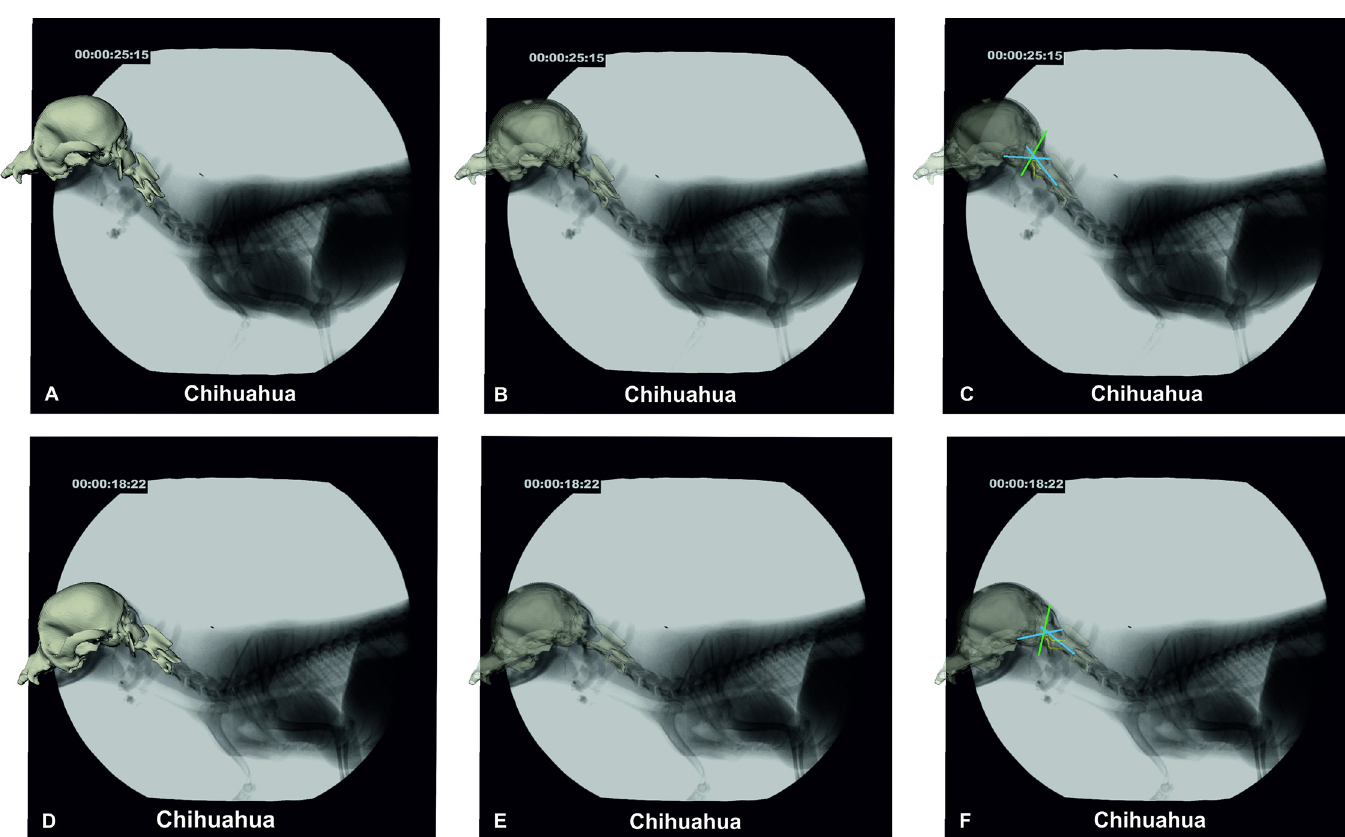
Fig 9. CCJ position in a walking Chihuahua. Images A–C: Ch6 in walk with an elevated neck position. Images D–F: Ch6 in walk with a lowered neck position. A/D: fluoroscopy image with superimposed bone model, B/E: semi-transparent bone model and transparent atlas, C/F: semi-transparent bone model and illustration of the (modified) McRae’s line (green line), Wackenheim’s clivus baseline (rostral blue line) and clivus canal angle (both blue lines, angle in image C and F: 129˚). The contour of the dens is highlighted in yellow. 90˚ camera position.